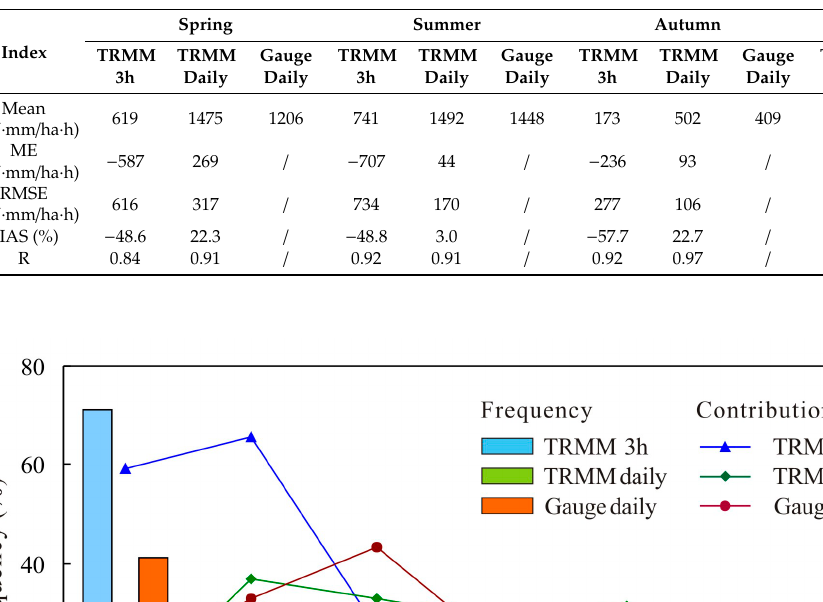
Table 1. Seasonal changes in bias between Tropical Rainfall Measuring Mission products (TRMM) and rain gauges data.